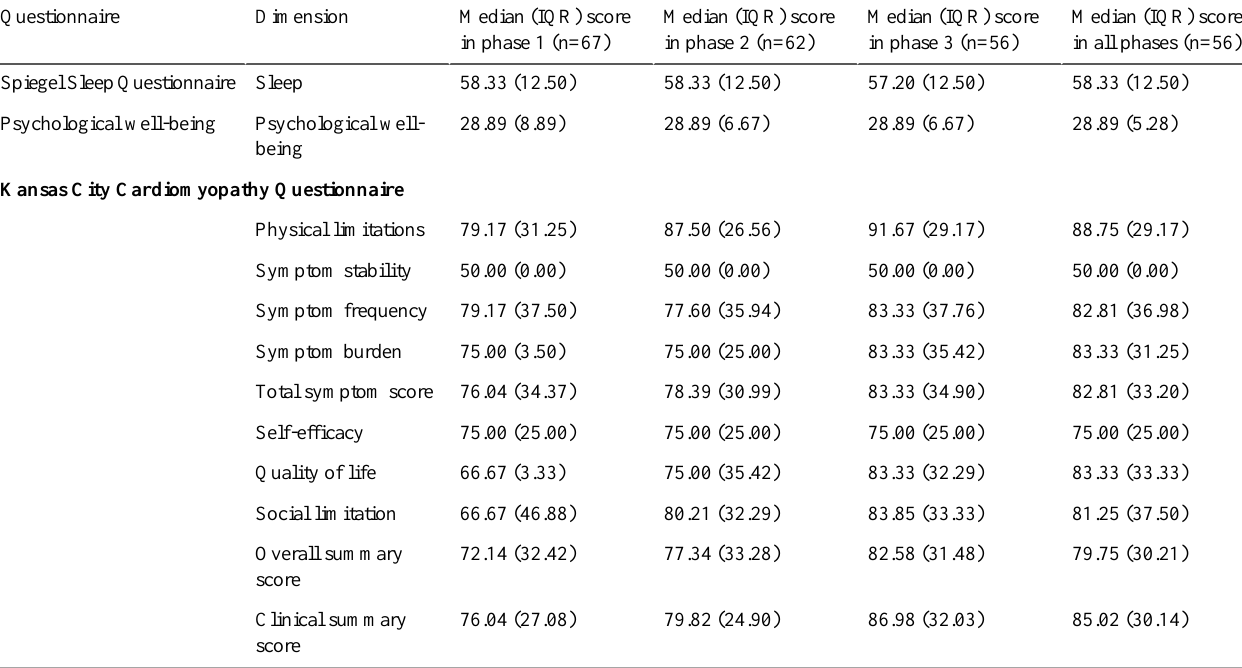
Table 2. Median (IQR) scores for all patient-reported outcome